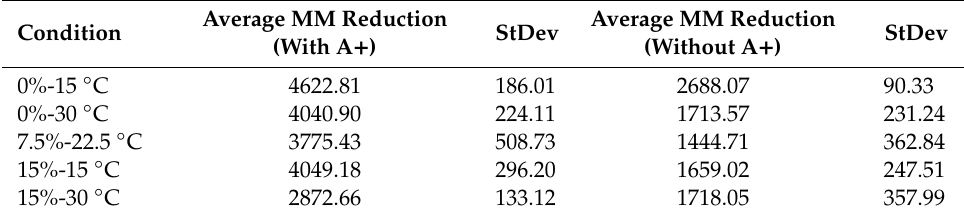
Table A4. Average reduction in molar mass of PA solutions due to adsorption. Values represented in Figure 8 ( n = 9). All “Without A + ” values were derived from a previous study [7]. “A + ” = anthocyanins, “MM” = Molar